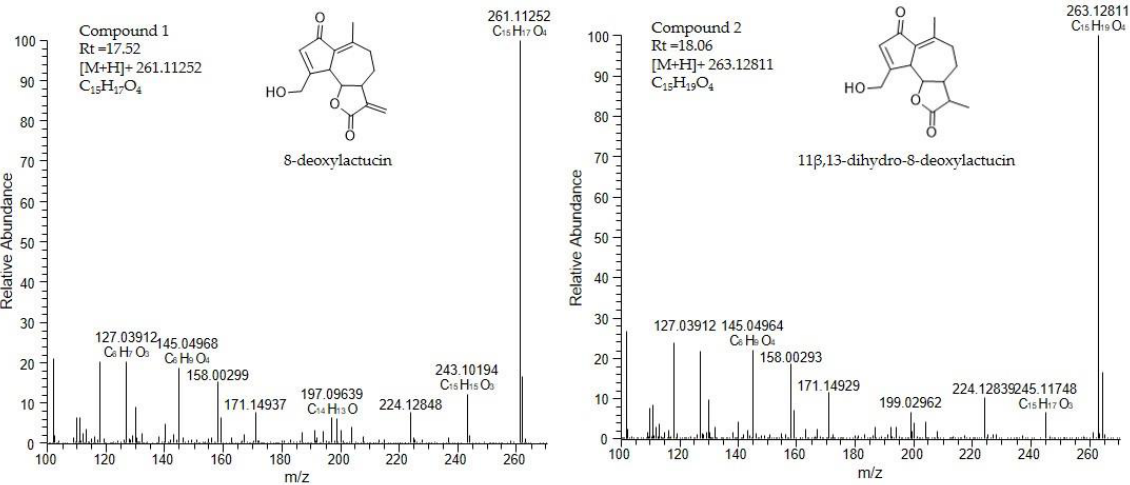
Figure 7. Mass spectrum of the compounds 1 and 2. Compound 1 was identified as 8-deoxylactucin, and compound 2 was identified as 11β,13 -dihydro-8-deoxylactucin.